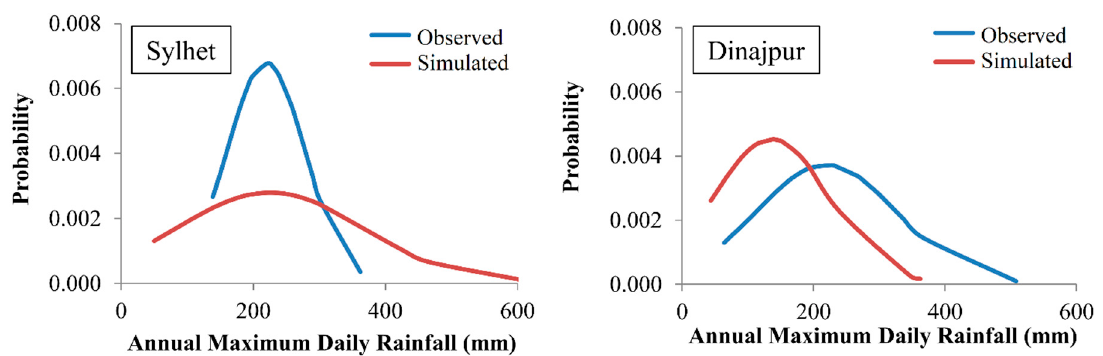
Figure 5. Comparison of probability density functions between observed and simulated annual maximum daily rainfalls at Sylhet ( left ) and Dinajpur ( right ) during the base period (1986–2005).